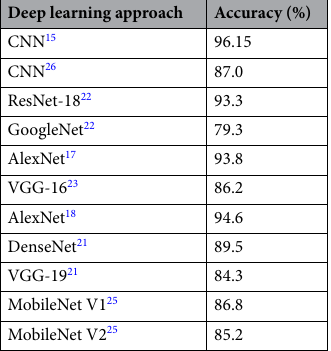
Table 2. Accuracies of various classification techniques used for breast cancer